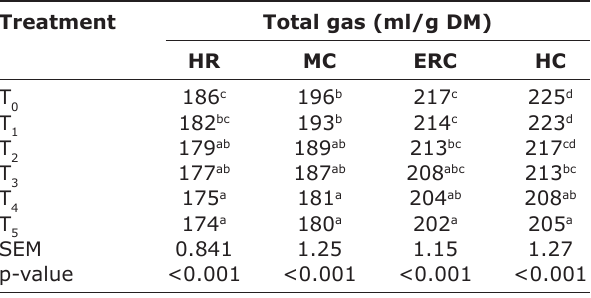
Table-4: Effect of silkworm pupae oil supplementation at graded levels with different dietary regimes on total gas production.